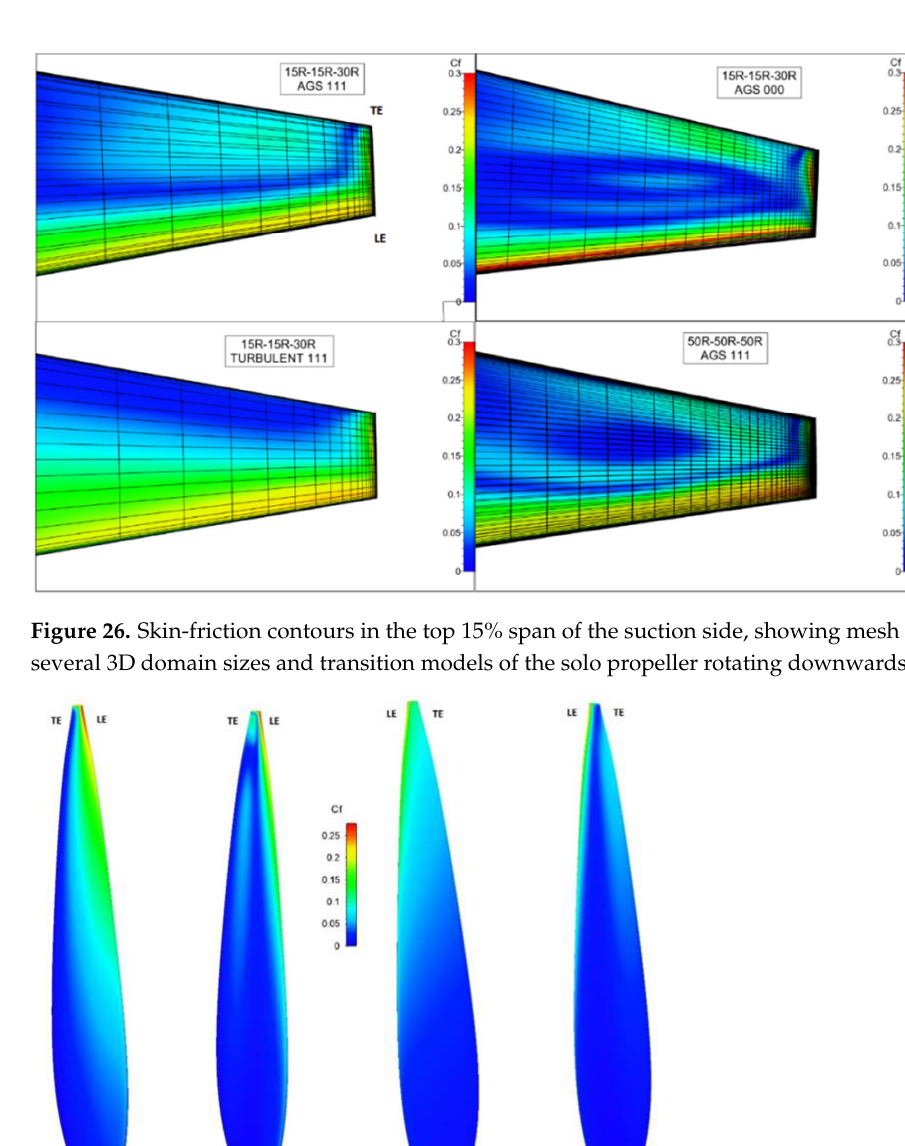
Figure 25. Contour plots (cid:1856)(cid:1830) (cid:1868)(cid:1870)(cid:1867)(cid:1858)(cid:1861)(cid:1864)(cid:1857)